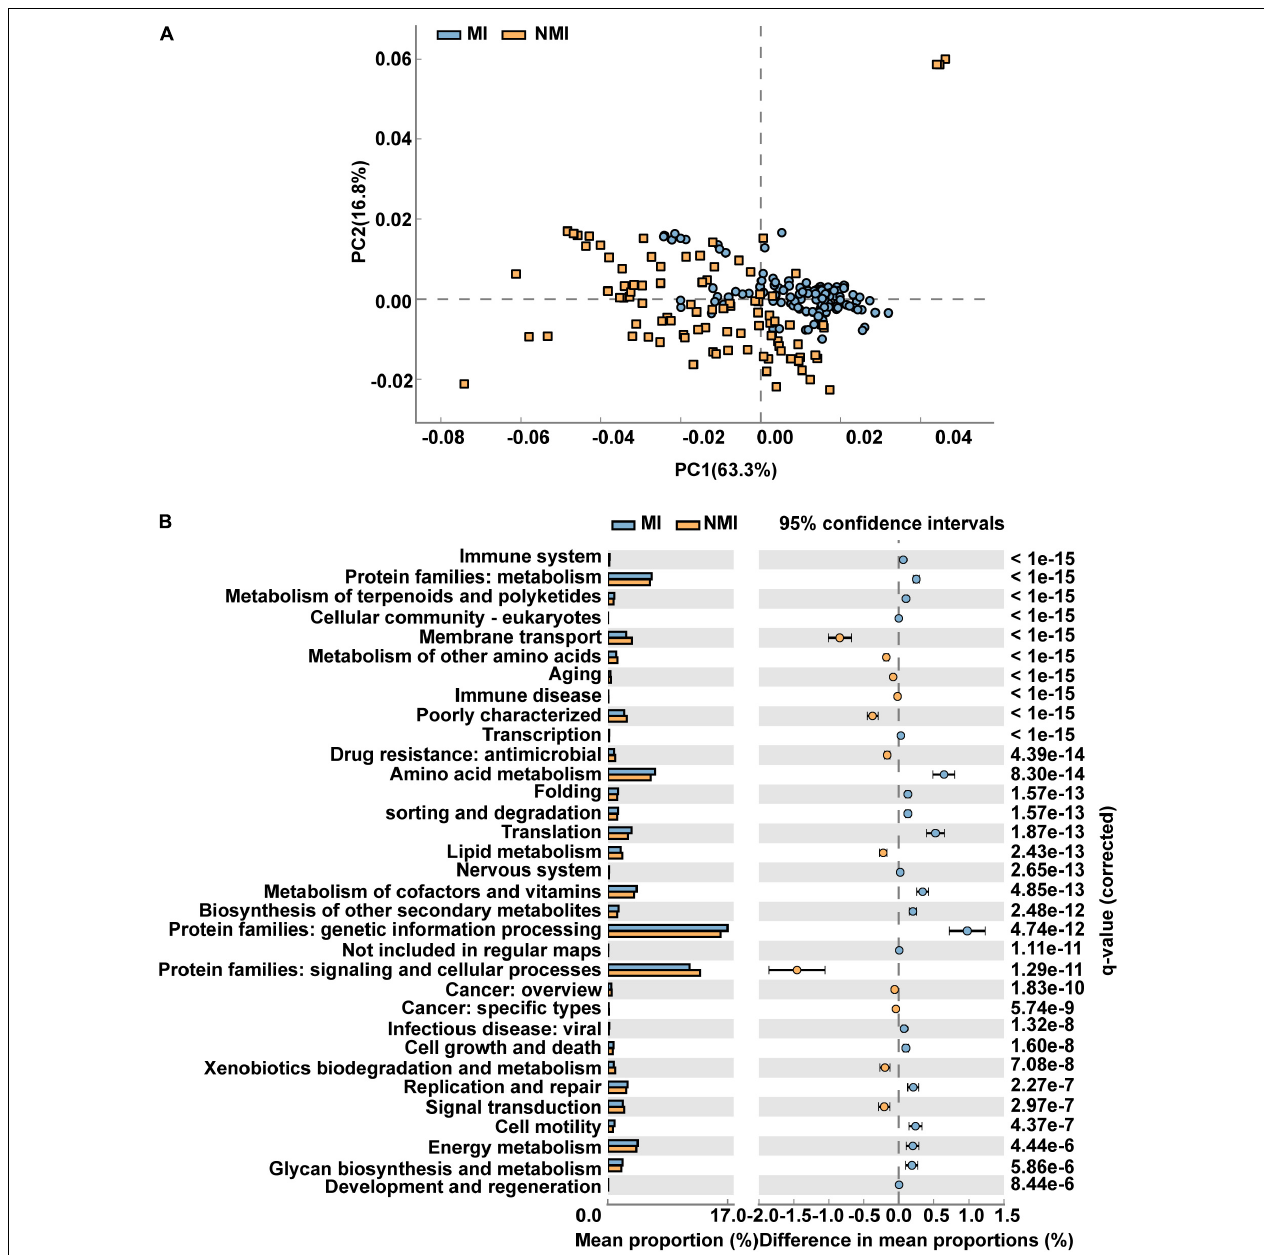
FIGURE 4 | Differential functional pathways of gut microbes in medicinal insect group (MI) and non-medicinal insect group (NMI) predicted by PICRUSt2. (A) PCA plot of differential functional pathways between MI and NMI group in PathwayL2. Blue indicates the medicinal insect gut microbiota and orange indicates the non-medicinal insect gut microbiota. (B) Extended histogram of differential functional pathways of MI versus NMI group in PathwayL2. The histogram indicates the mean proportion (%) of differential MetaCyc pathways predicted by PICRUSt2. Differences between groups are shown with 95% confidence intervals, and only the fractions with p < 0.00001 corrected for Storey FDR using Welch’s t -test are shown. Blue indicates the medicinal insect gut microbiota, and orange indicates the non-medicinal insect gut